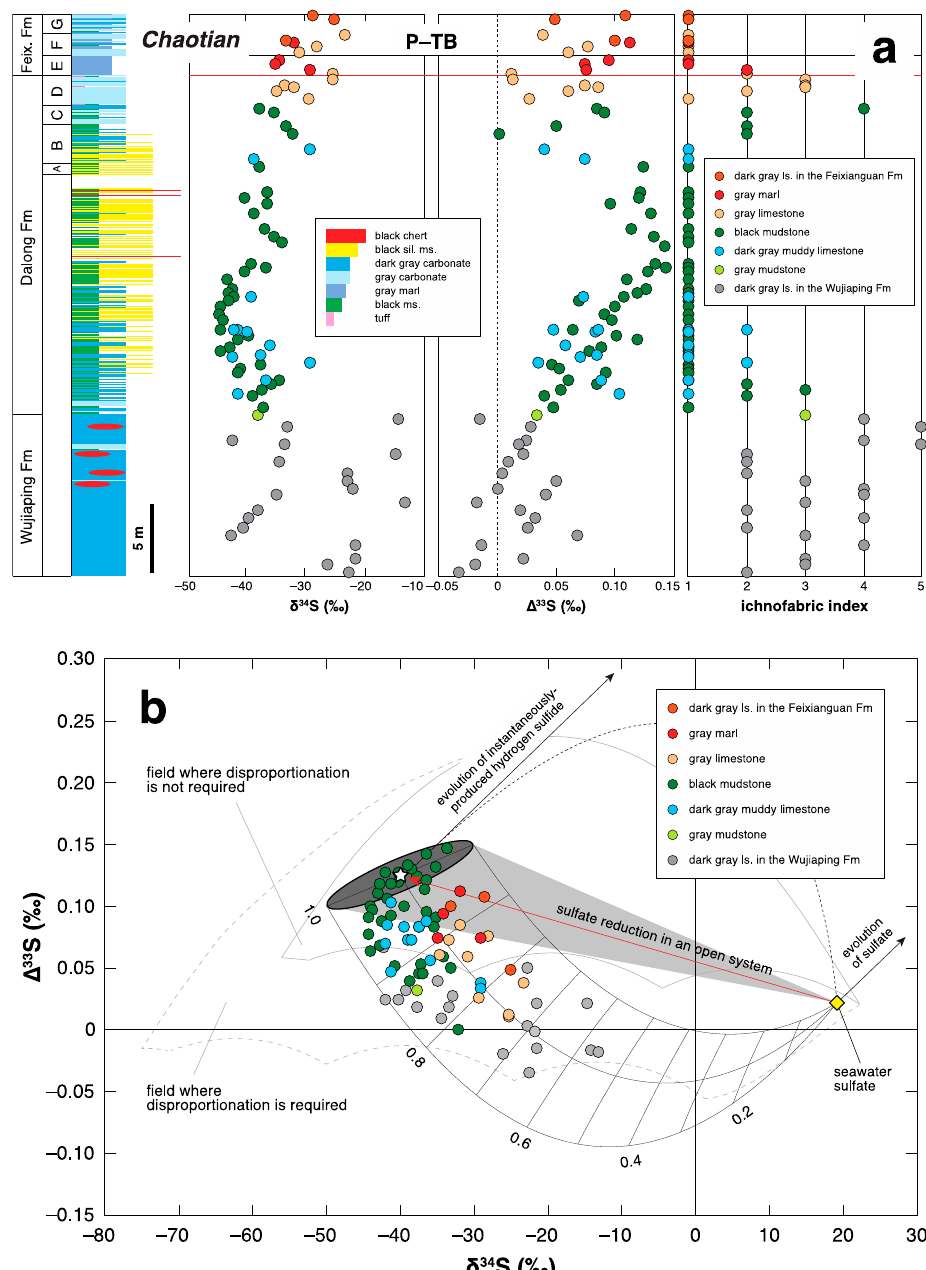
Figure 10. Multiple sulfur isotope record across the P-TB at Chaotian [122]. ( a ) sulfur isotope chemostratigraphy. A red line represents the extinction horizon. Alphabet along the log is unit name. Feix.: Feixianguan; ( b ) δ 34 S– ∆ 33 S cross plot. A diamond represents the estimated contemporaneous seawater sulfate with the δ 34 S and ∆ 33 S values of +19.2‰ and +0.022‰, respectively [68]. A star shows instantaneously produced sulfide via the seawater sulfate reduction assuming that the 34 ε and 33 λ values are 58.1‰ and 0.513, respectively (red arrow), although its δ 34 S and ∆ 33 S values are not strictly constrained (gray circle). Solid black arrows represent the evolution of the remaining sulfate and the instantaneously produced H 2 S, and a black dashed convex upward curve shows the evolution of accumulative H 2 S produced via MSR in a closed system. Black convex downward curves are a mixing curve between the two endmembers: sulfide produced via quantitative MSR and instantaneously produced H 2 S in an open system. A number on the curves represents a portion of the latter endmember on the mixing. Fields where disproportionation is required and not required are from Zhang et al. [67]. Note that the negative ∆ 33 S signals are observed in the oxic Wujiaping limestones, as in the case of the G-LB interval at Chaotian (Figure